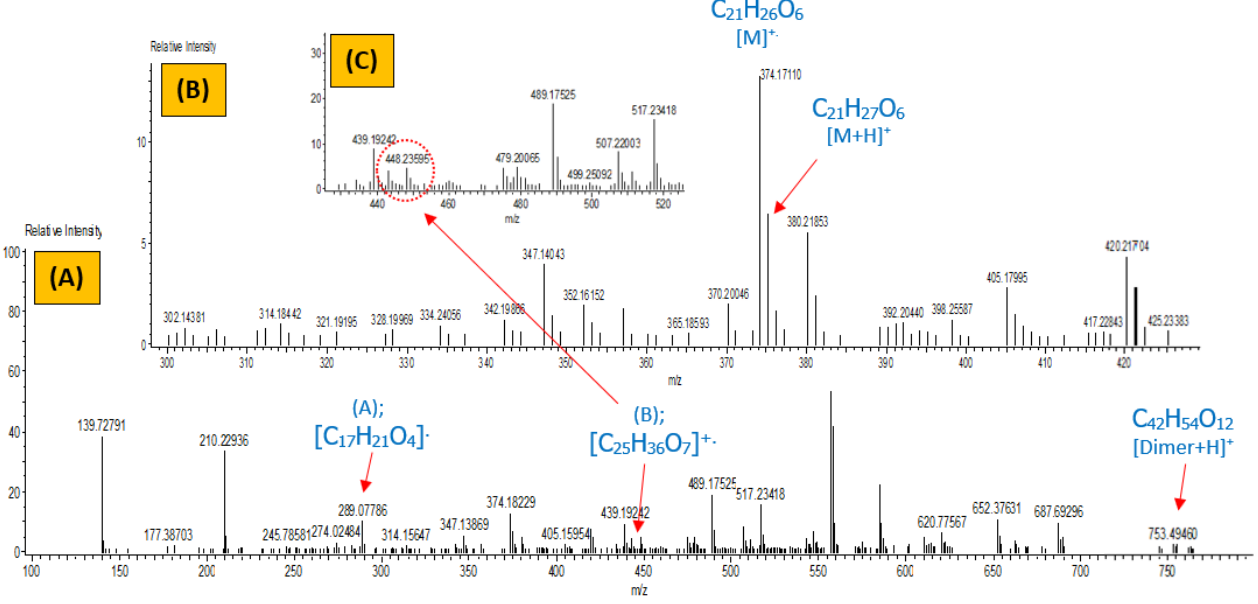
Figure 5. Mass spectra of EgGAA monomer: ( A ) full fragmentation pattern, ( B ) molecular ion region, and ( C ) peak-B region.